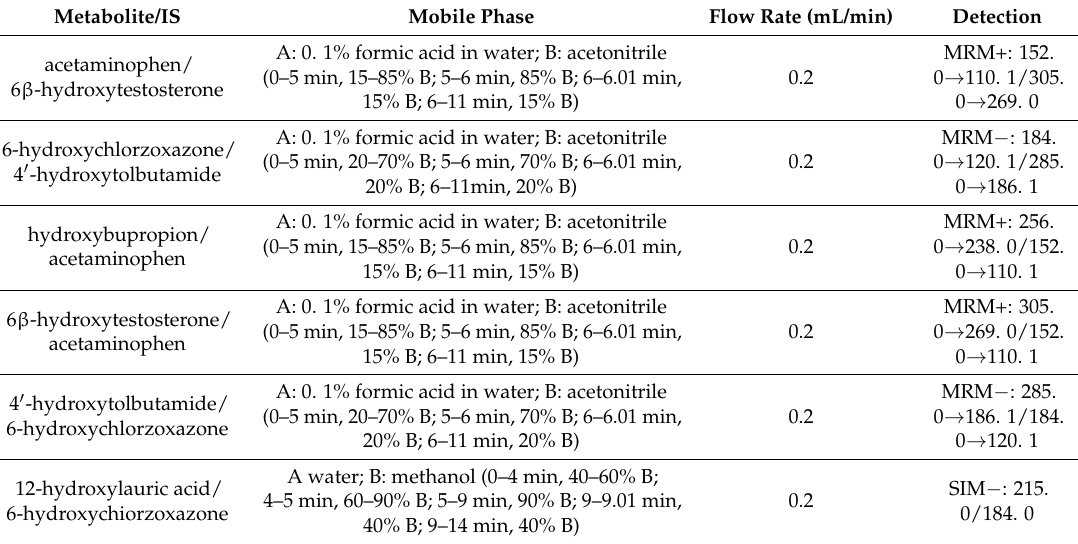
Table 5. The methods of the content analysis of metabolites